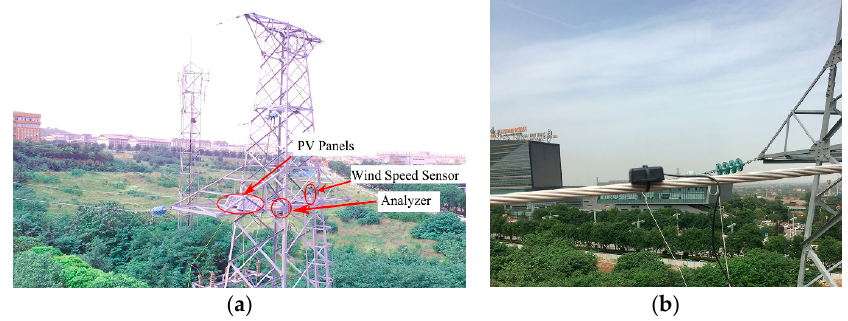
Figure 10. Field test of the FBG-based monitoring system. ( a ) Tower; ( b ) FBG-based acceleration sensor.